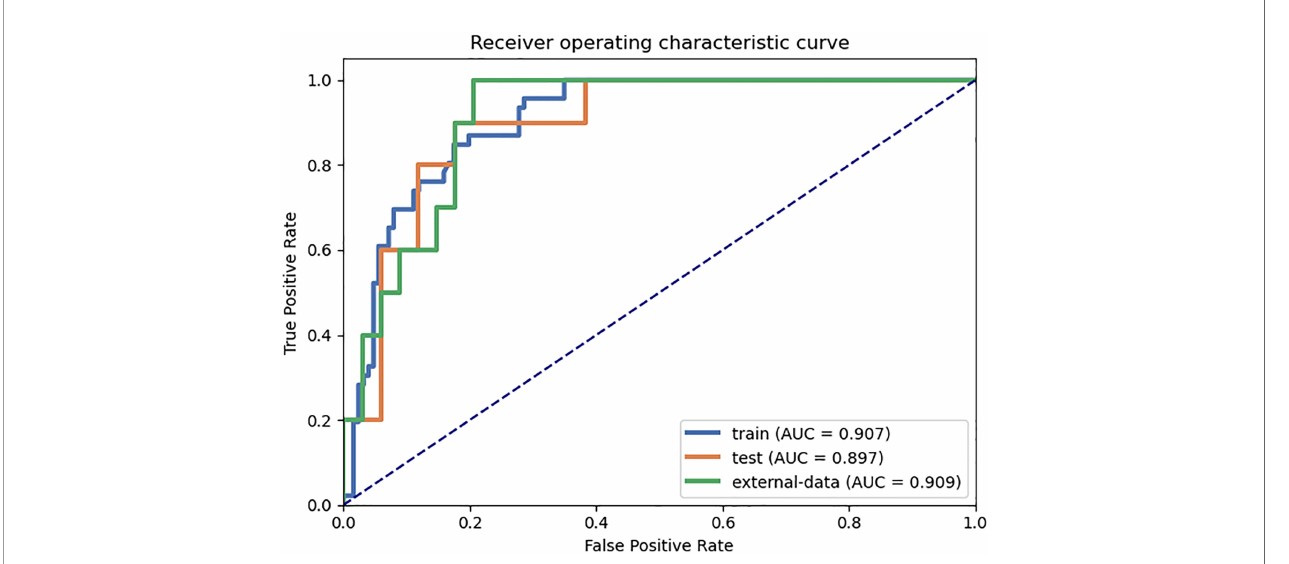
FIGURE 4 | The eight-VOI radiomic model achieved the best diagnostic performance. The AUCs of the eight-VOI model were 0.907 (95%CI, 0.862 – 0.947) in the training set, 0.897 (95%CI, 0.784 – 0.985) in the testing set, and 0.909 (95%CI, 0.863 – 0.949) in the external validation set, and the diagnostic accuracy in the external validation set was